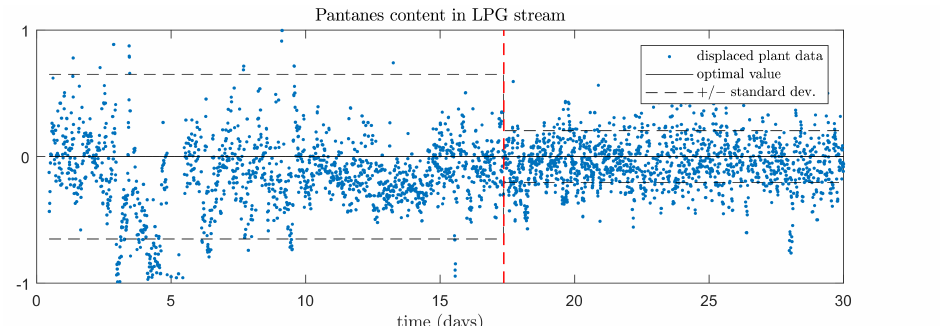
Figure 10. Optimization results: pentanes content in LPG deviated from the optimal value before and after the RTO loop closing.